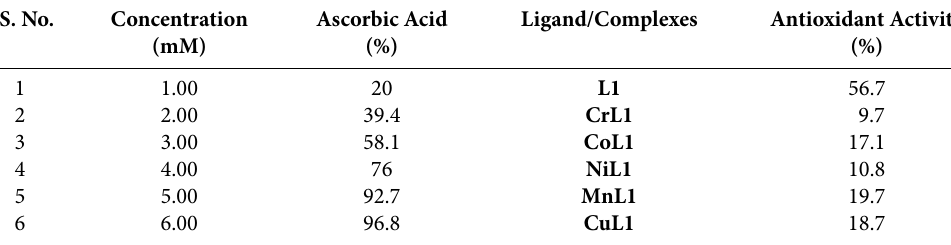
Table 4 . Antioxidant activity of MBHA (compound 3 ) and its formed metal complexes (compound 4-8 ) S. No.